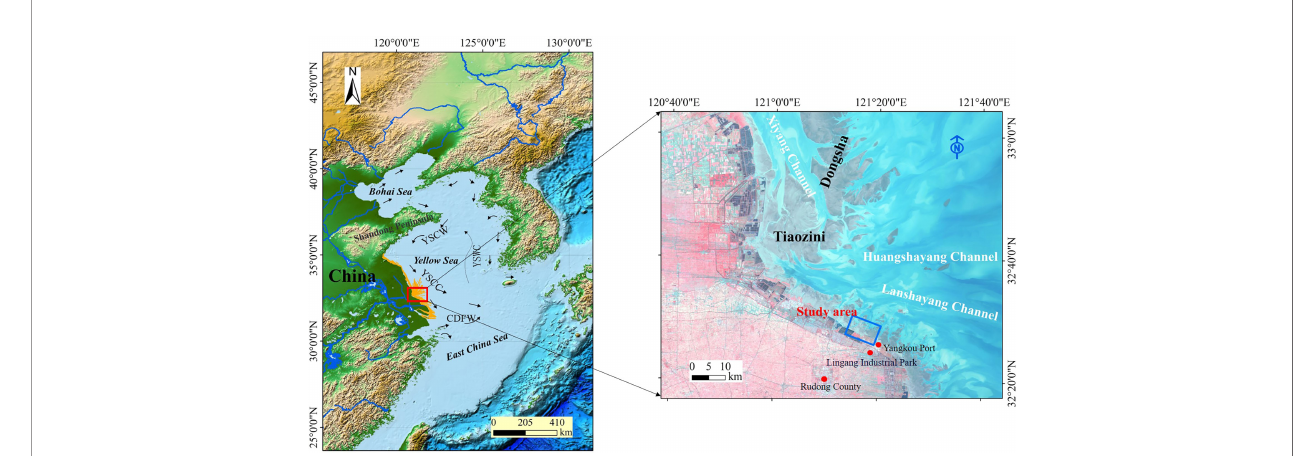
FIGURE 1 | The map of study